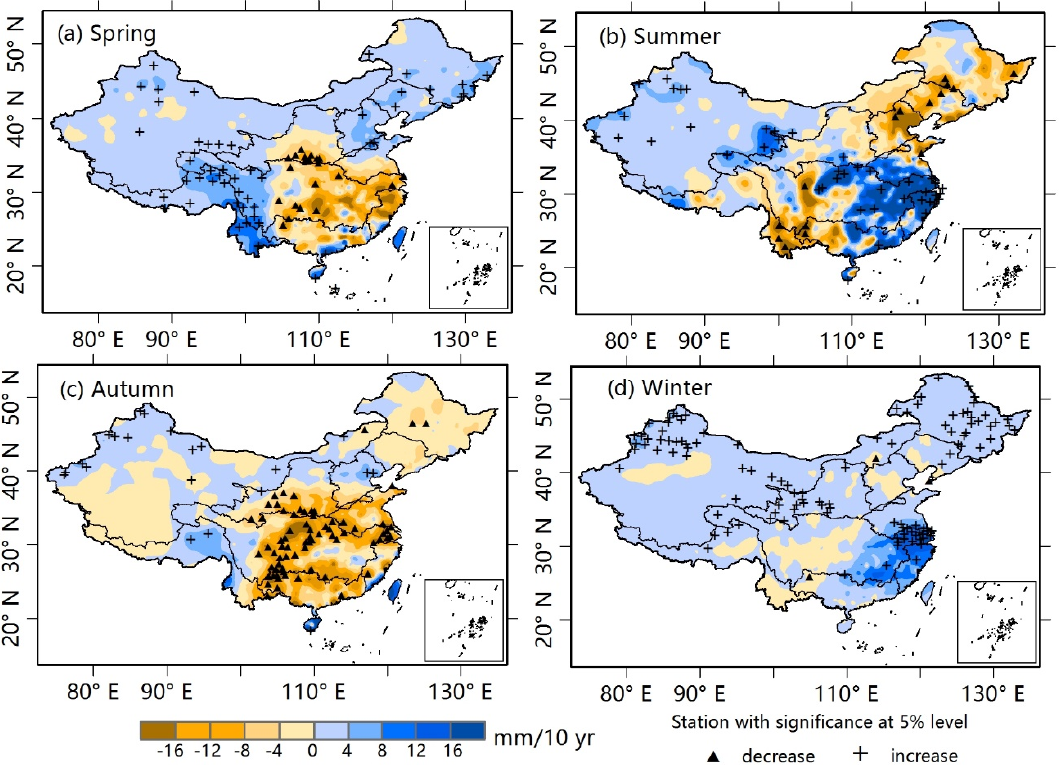
Figure 5. Trends in seasonal precipitation during 1960–2013. ( a ) Spring; ( b ) summer; ( c ) autumn; and ( d ) winter. Table 2. Seasonal precipitation trends over China’s large river basins during 1960–2013 (mm/10yr).